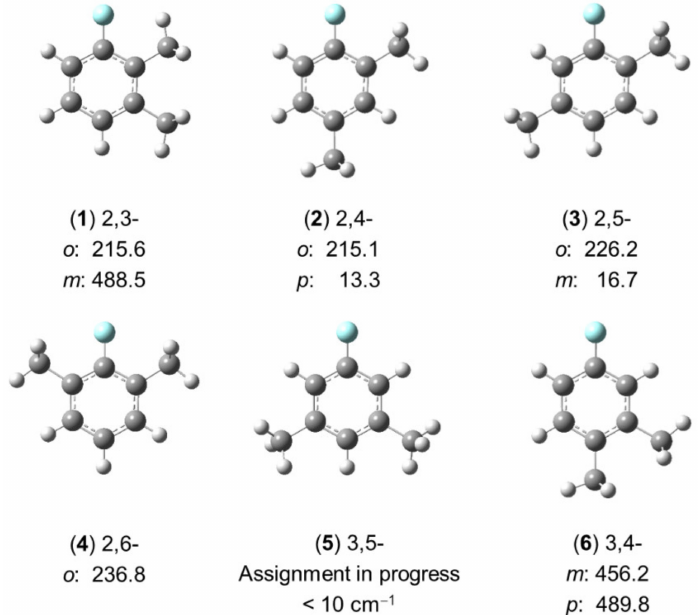
Figure 15. Torsional barriers of the methyl groups in six isomers of dimethylfluorobenzene (in cm − 1 ). ( 1 ) 2,3-dimethylfluorbenzene [78], ( 2 ) 2,4-dimethylfluorobenzene [201], ( 3 ) 2,5-dimethyl- fluorobenzene [202], ( 4 ) 2,6-dimethylfluorobenzene [80], ( 5 ) 3,5-dimethylfluorobenzene, and ( 6 ) 3,4- dimethylfluorobenzene